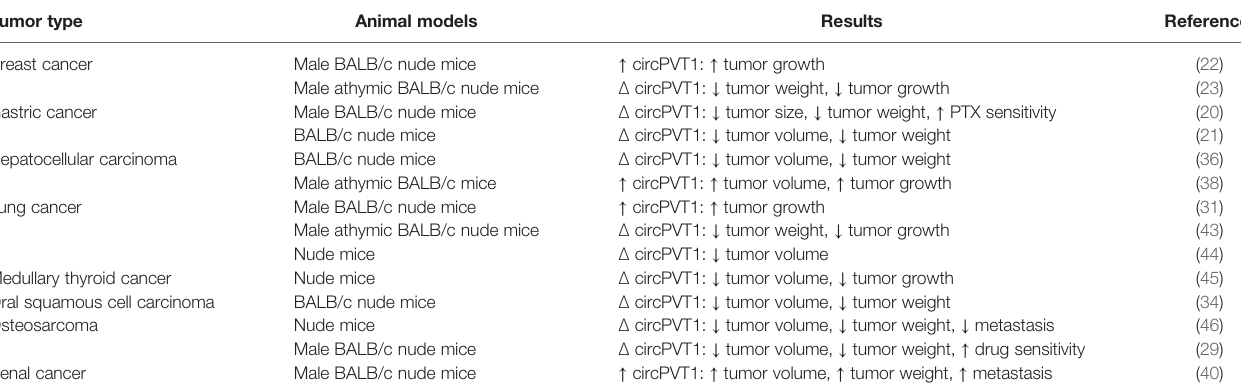
TABLE 2 | Impact of circPVT1 carcinogenesis based on animal studies.